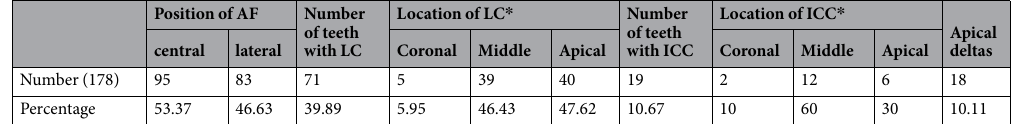
Position of AF Number